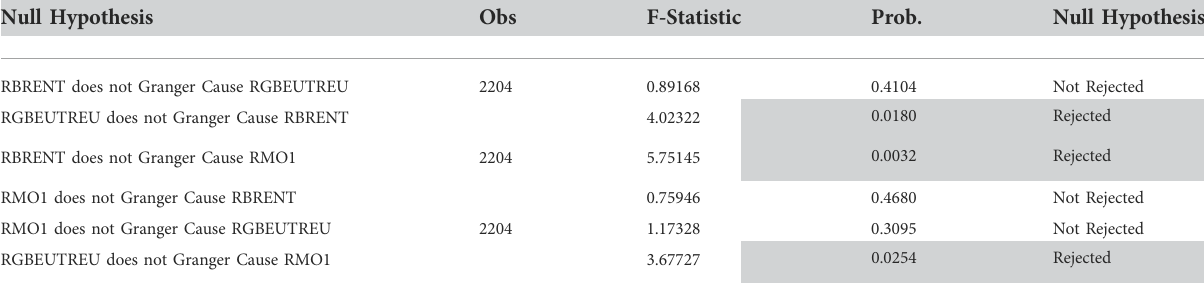
TABLE 4 Pairwise granger causality tests